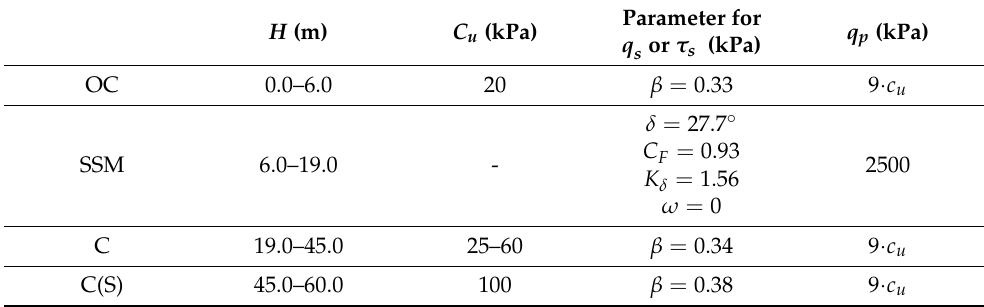
Table 2. Geotechnical parameter for pile-bearing capacity